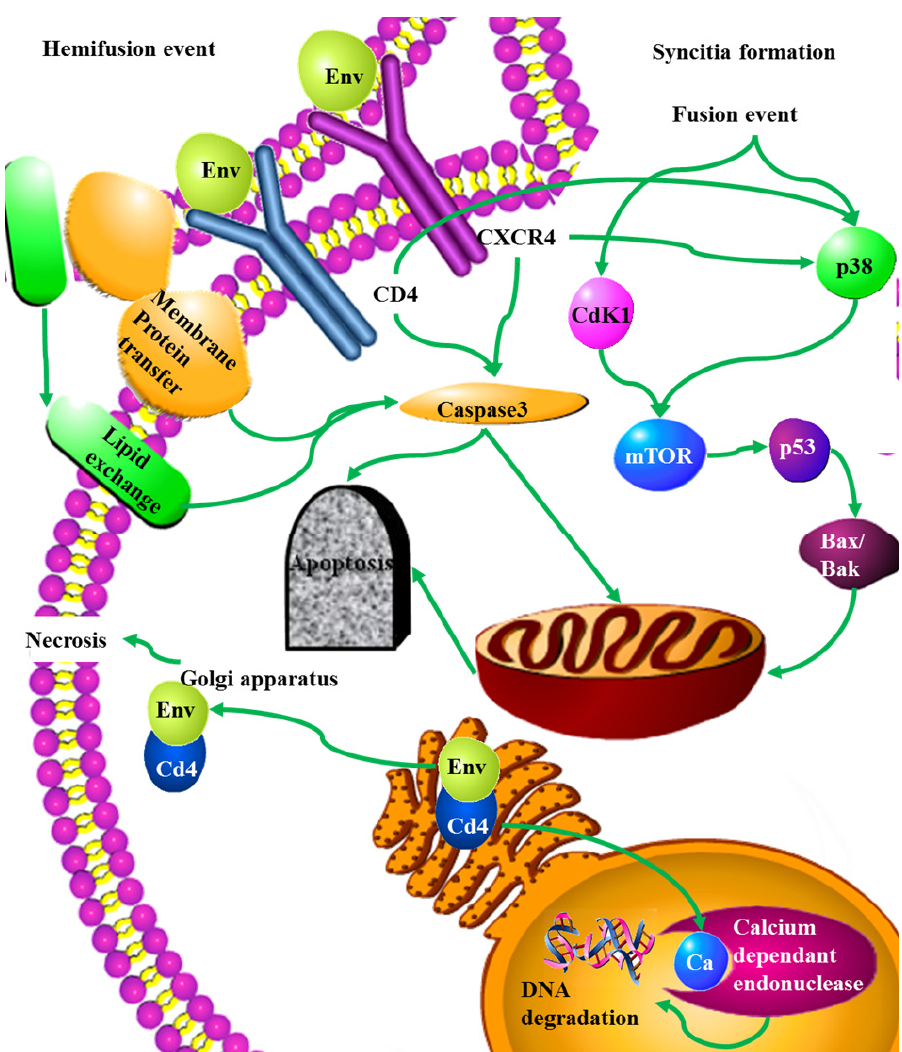
Figure 3. Mechanisms of apoptosis induction by the HIV-1 envelope protein at the cell surface. This can result from a hemifusion event through the transient interaction between Env- and CD4/CXCR4. This hemifusion event results in the exchange of membrane lipids and proteins. Alternately, Env-expressing cells can fuse with Env-negative cells resulting in the formation of a syncytium and death for the new fused cell. Here cell death relies on the p53 pathway via p38 and Cdk1